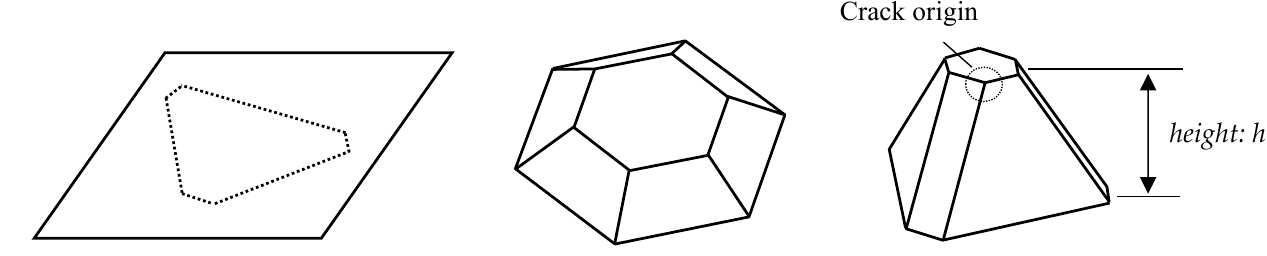
Figure 3. A truss core panel formed using a two-stage progressive deep drawing method.